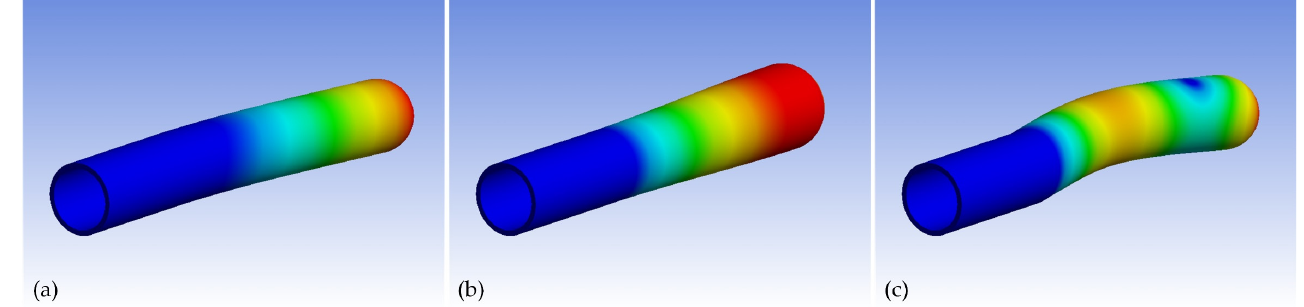
Figure 13. The mode shapes of the primary resilient bladder: ( a ) 1st mode, ( b ) 11th mode, and ( c ) 12th mode.